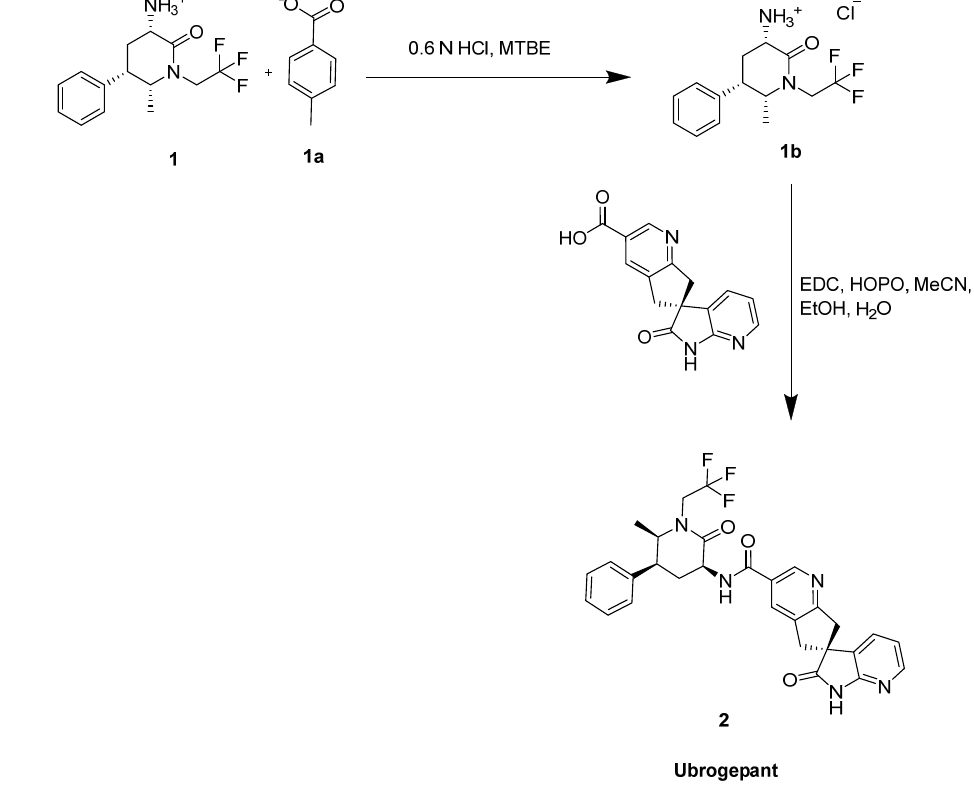
Figure 1. Synthesis and structure of ubrogepant.